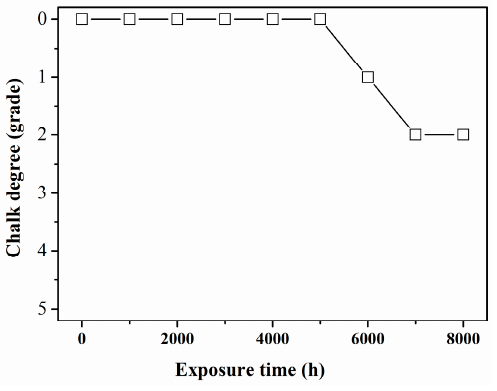
Figure 12. Coating chalk after the QUV test.